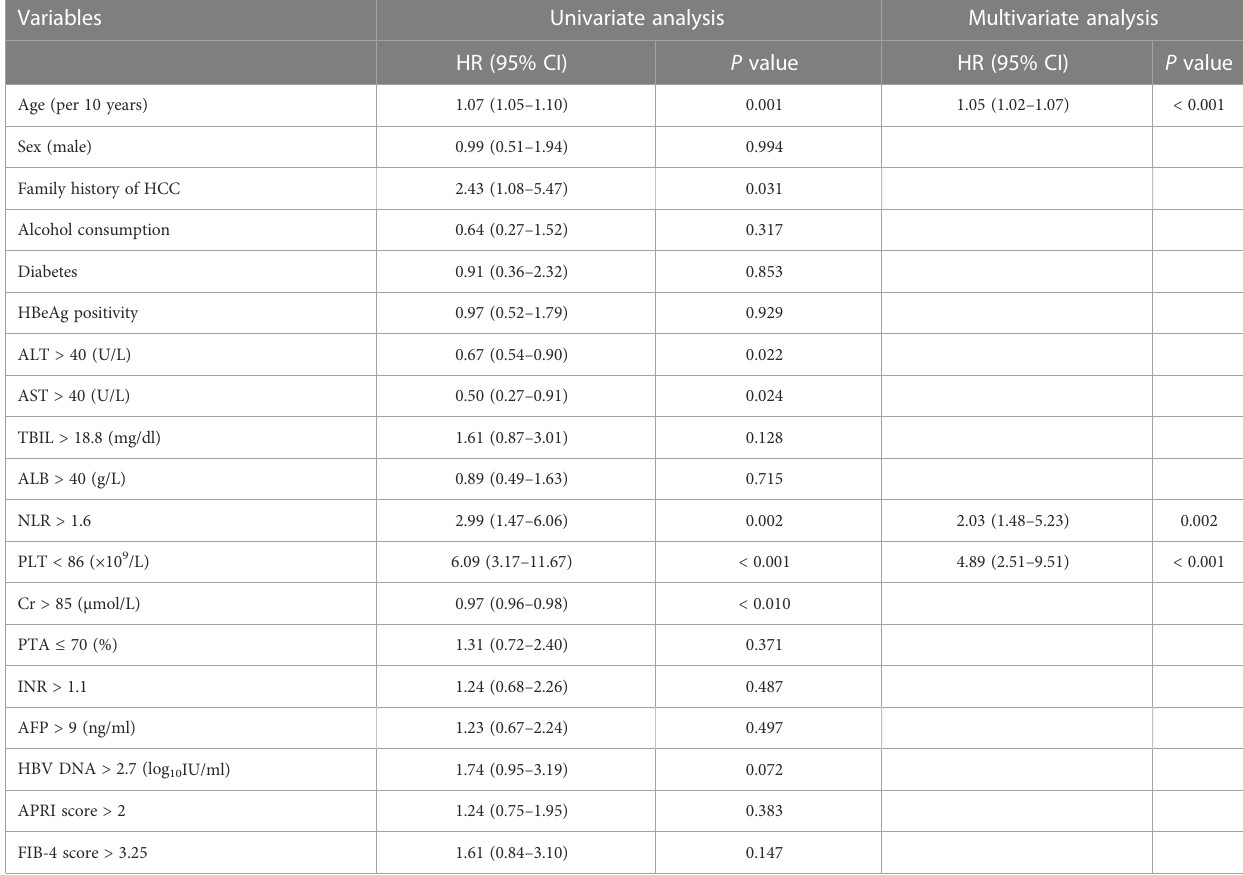
TABLE 2 Univariate and multivariate analyses of risk factors for the occurrence of hepatocellular carcinoma.